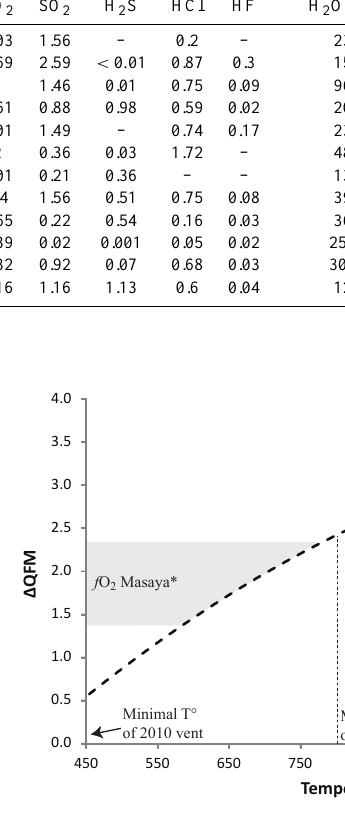
Table 3. Gas emission composition (in mol%) and molar ratio from several arc volcanoes. Data from Turrialba (this study), Villarrica (Sawyer et al., 2011), Poas (Symonds et al., 1994), Momotombo (Menyailov et al., 1986), Masaya (Martin et al., 2010), Soufriere Hills (Hammouya et al., 1998), Mt St Helens (Gerlach and Casadevall, 1986), Kudryavy (Taran et al., 1995), Usu (Symonds et al., 1994), Showa-shinzan (Symonds et al., 1996), Satsuma Iwo Jima (Shinohara et al., 1993) and Merapi (Le Guern et al., 1982). Arc volcanoes Magma Temperature ( ◦ C) Plume composition (mol%) Turrialba (2013)